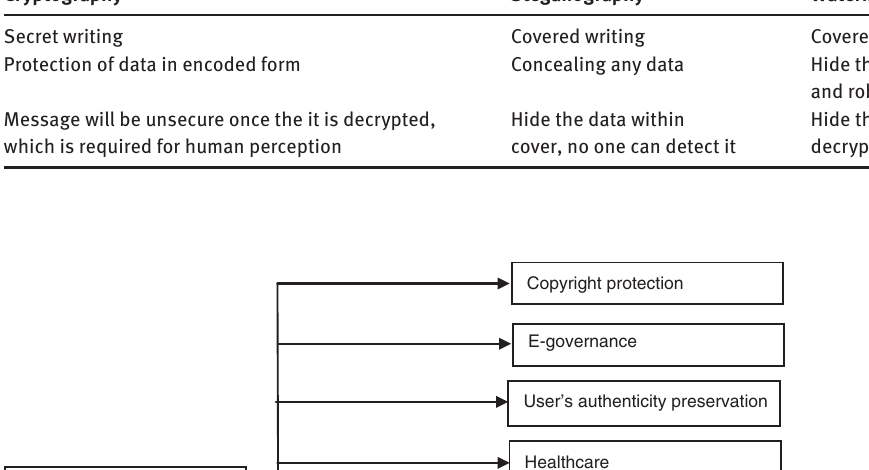
Table 1: Essential Difference between Cryptography, Steganography, and Watermarking.